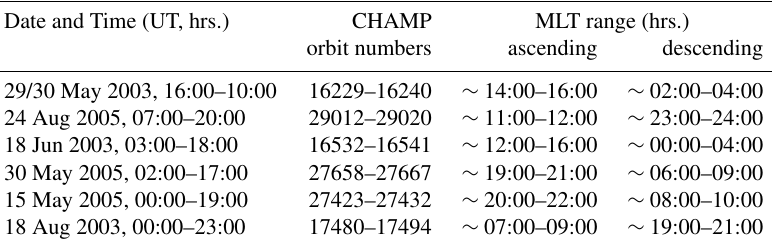
Table 1. Overview of CHAMP satellite orbits used for this study. Date and Time (UT, hrs.) CHAMP MLT range (hrs.) orbit numbers ascending